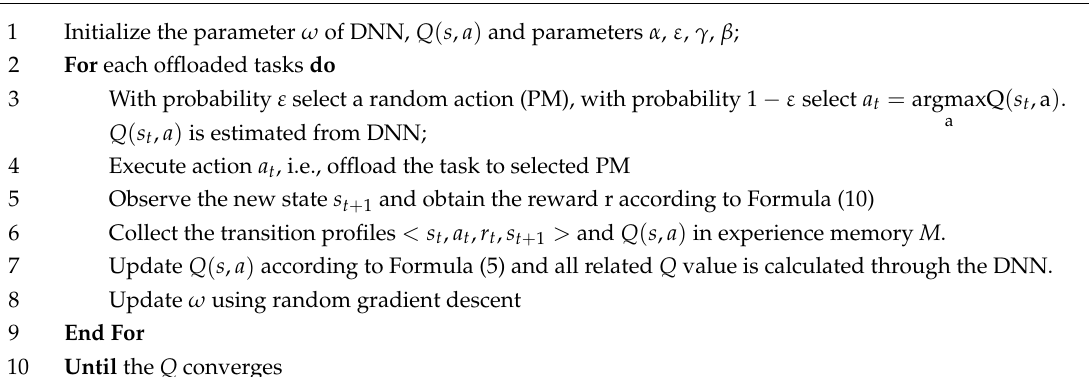
Algorithm 1. Task offloading algorithm based on deep reinforcement learning